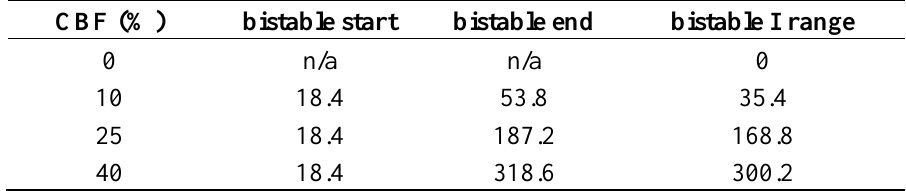
Table 3. Ranges of bistability for the four measured injury